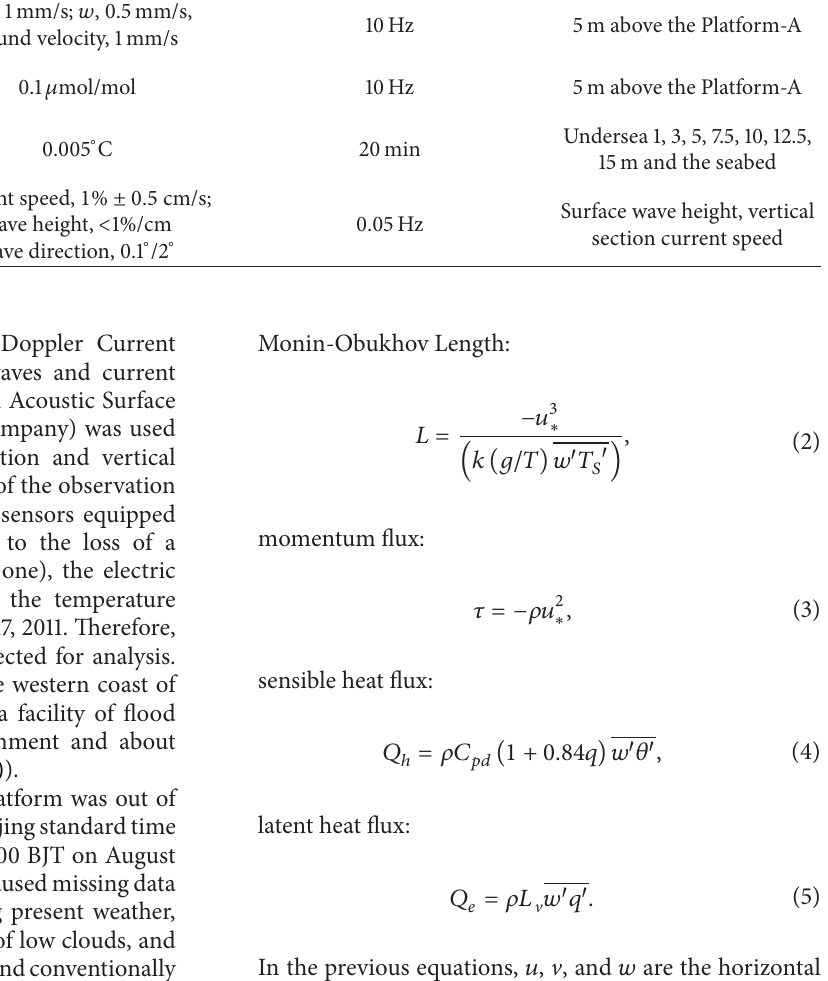
Table 1: List of instruments used during the intensive observations on air-sea fluxes.